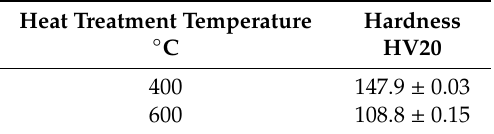
Table 2. Vickers hardness of Al / Cu alloy surface after heat